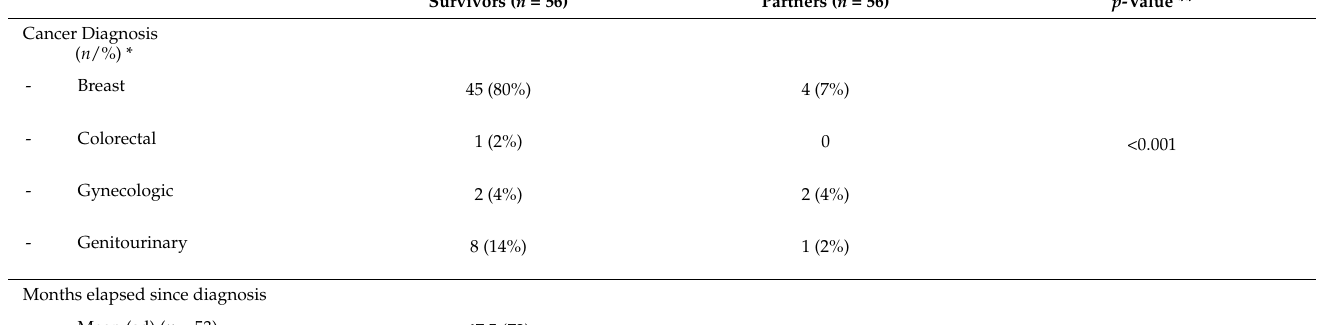
Table 3. Study sample characteristics of DUET cancer survivors and partners